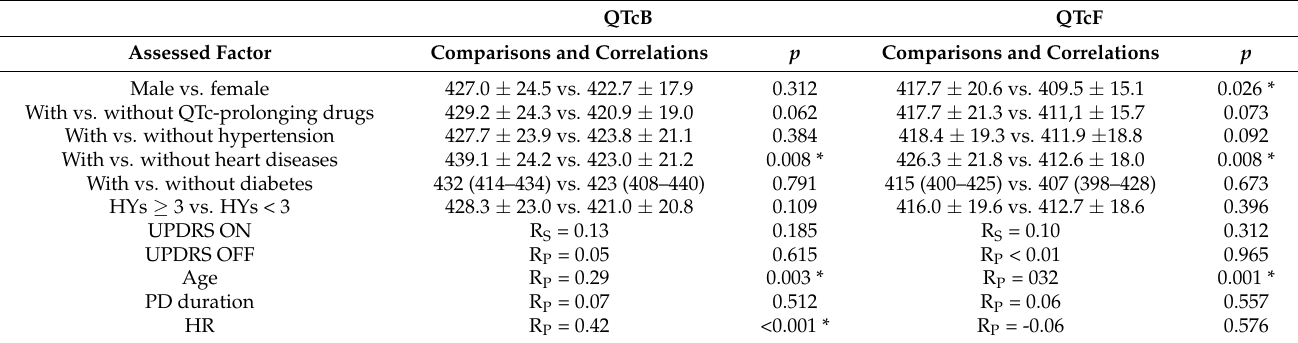
Table 4. Bivariate analysis for QTcB and QTcF.